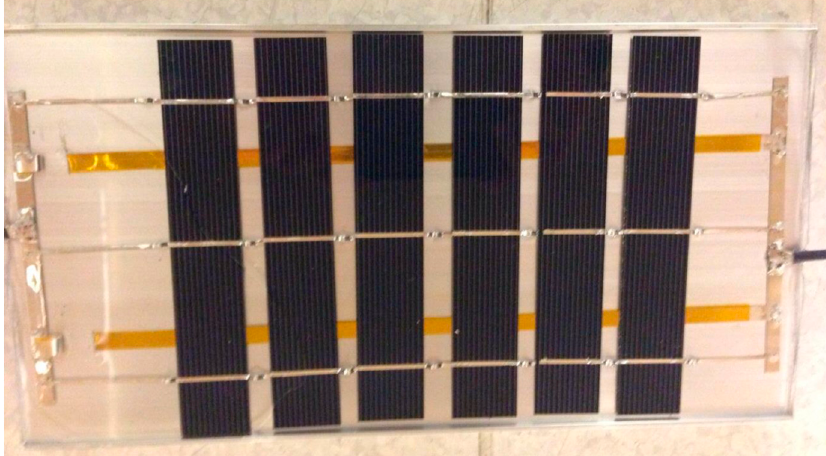
Figure A5. Receiver 5 has six 1/6 cells with a larger cell gap, line soldering, transparent silicon only and strain relief.